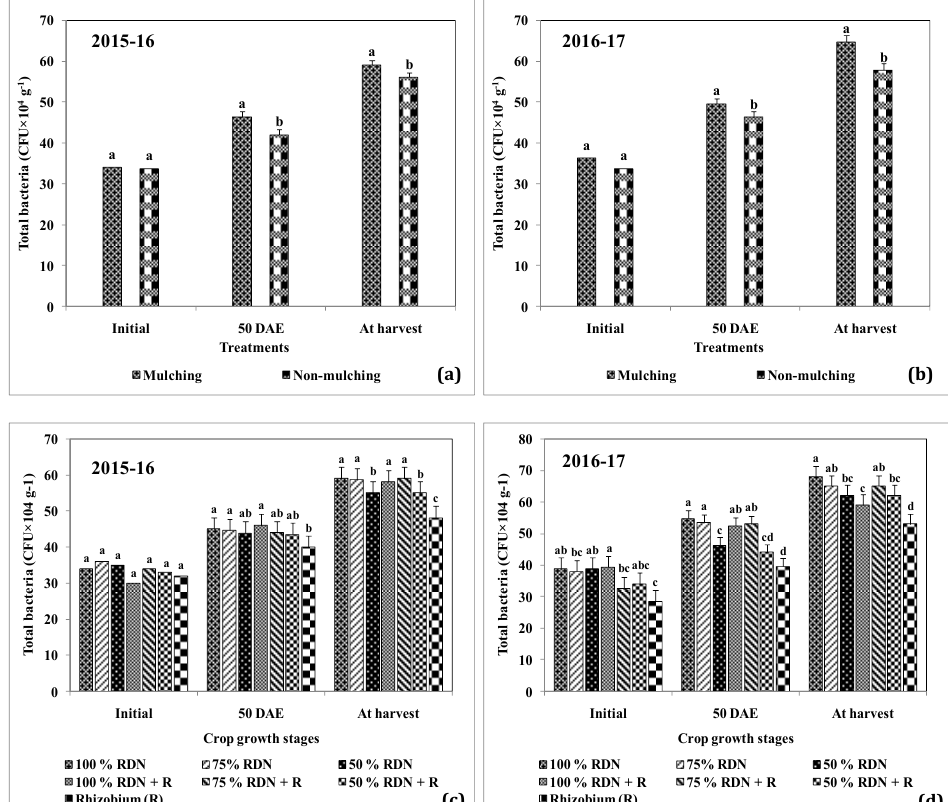
Figure 2. Effect of mulching ( a , b ) and nutrient doses ( c , d ) on soil bacterial populations at different growth stages of peanut (data from the 2015–2016 and 2016–2017 crop seasons, respectively); DAE—Days after emergence; within treatments, different letters indicate significant differences at p ≤ 0.05 (otherwise statistically at par); error bars represent the least significant difference value.